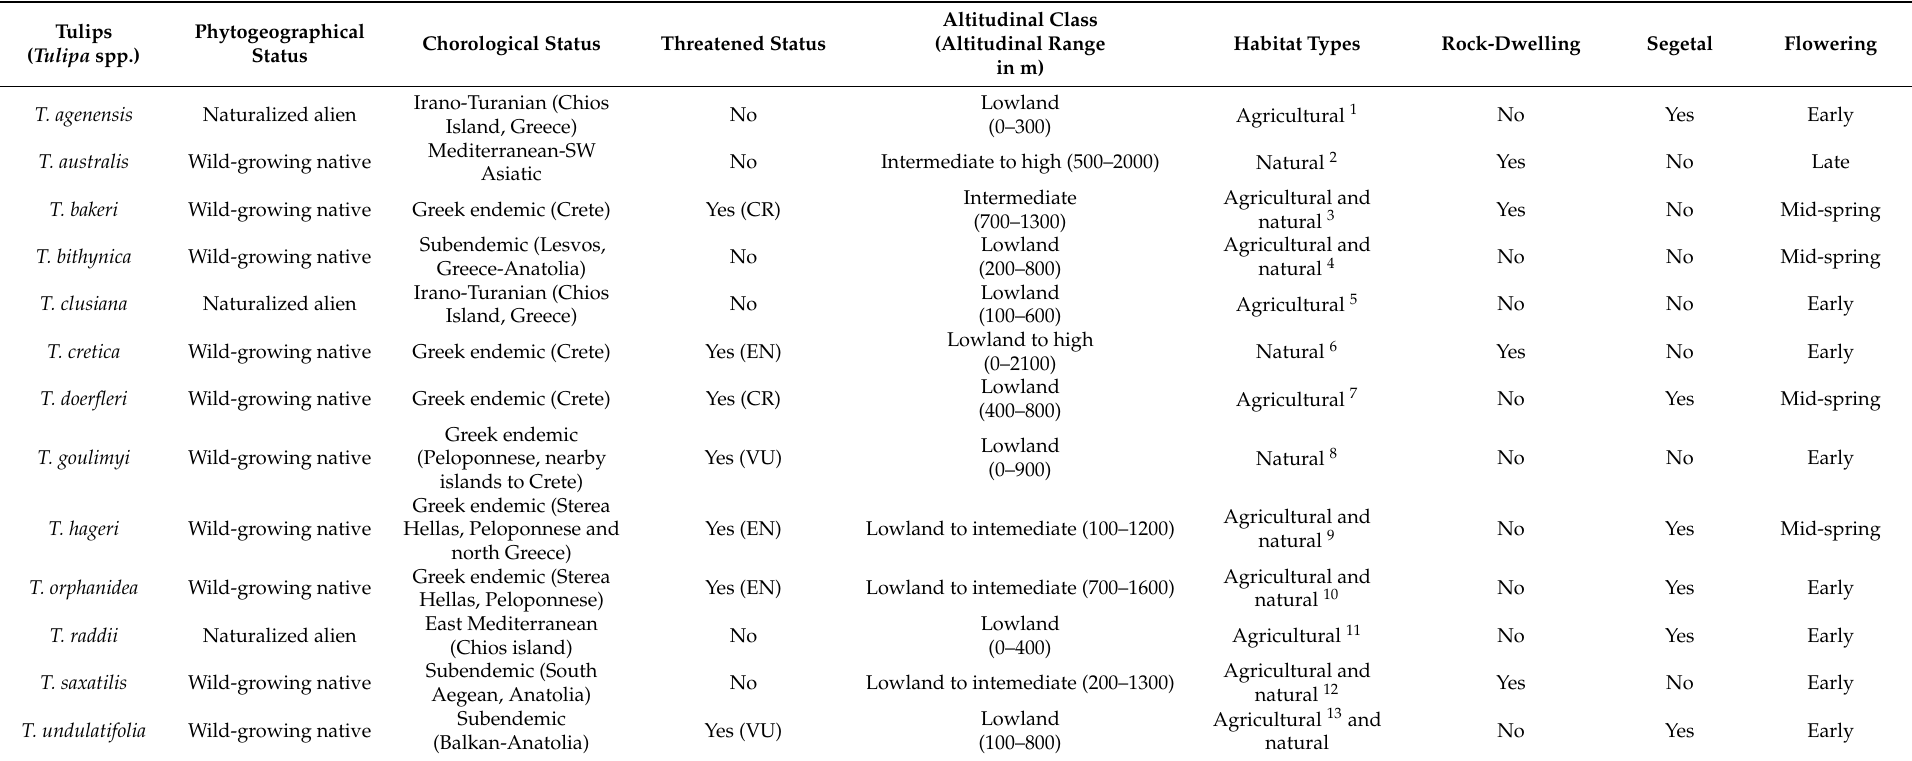
Table 2. Overview of the functional groups of the sampled wild-growing Greek tulip species ( N = 13) based on biological (taxonomical, phytogeographical, chorological, and ecological) data [2] and threatened status according to IUCN (International Union for the Conservation of Nature) extinction risk assessments [3,4]: CR—critically endangered; EN—endangered; VU—vulnerable. Tulips ( Tulipa